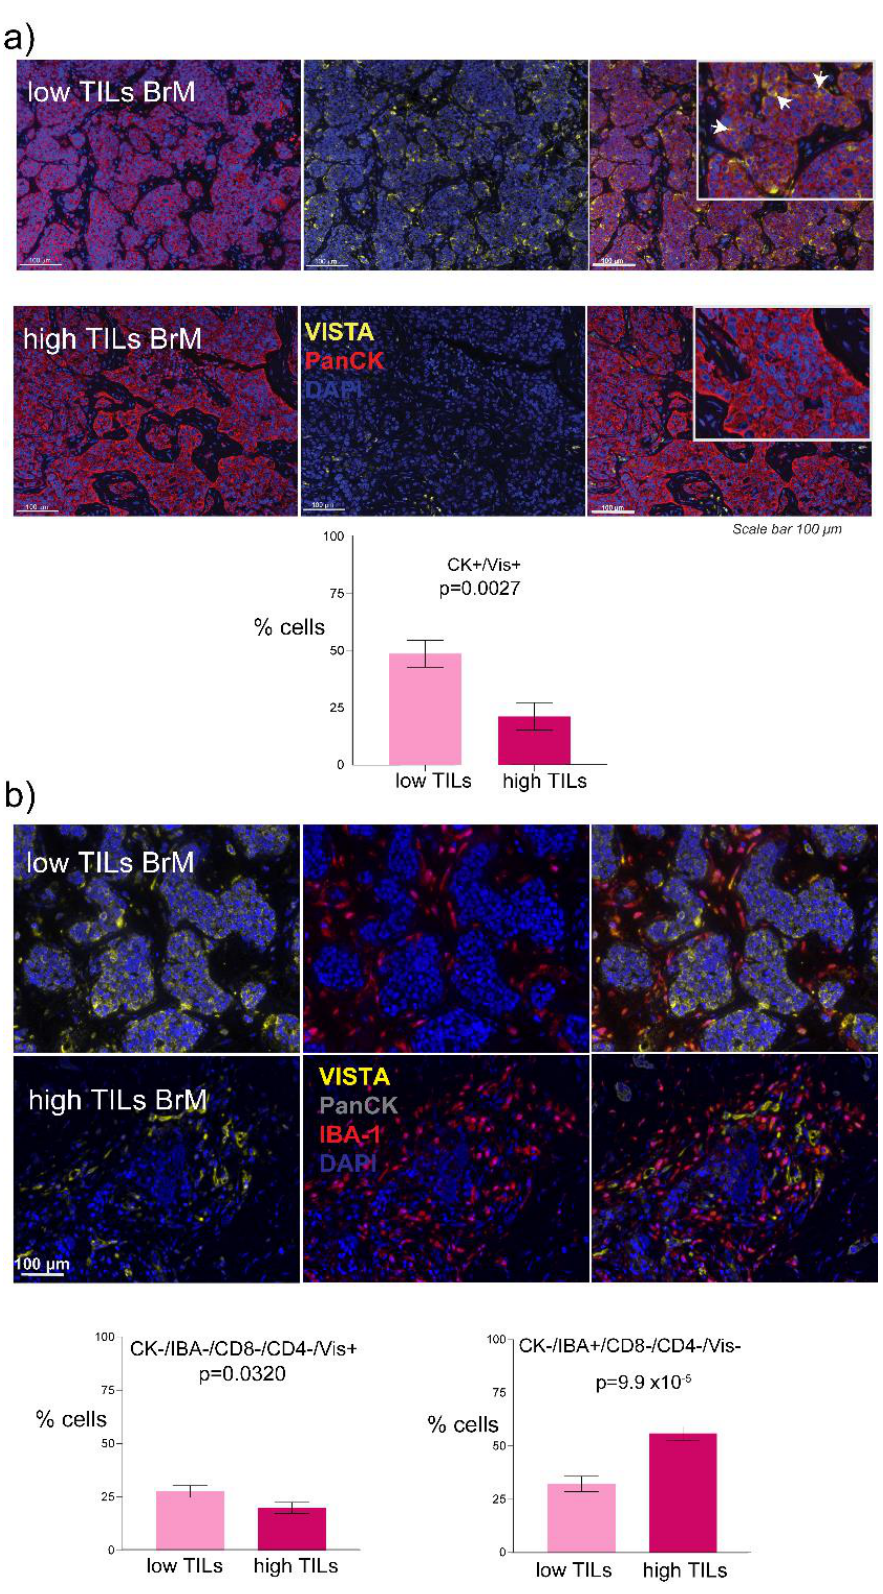
Figure 3. VISTA and Iba1+ cellular subtypes. ( a ) VISTA expression on the tumor cell surface of the low vs. high TIL groups and the associated bar graph; arrows indicate vista positive tumor cells. ( b ) Images represent the expression of VISTA and IBA1+ cells and bar graphs show VISTA and IBA1+ exclusive cells between the low and high TIL groups, respectively.